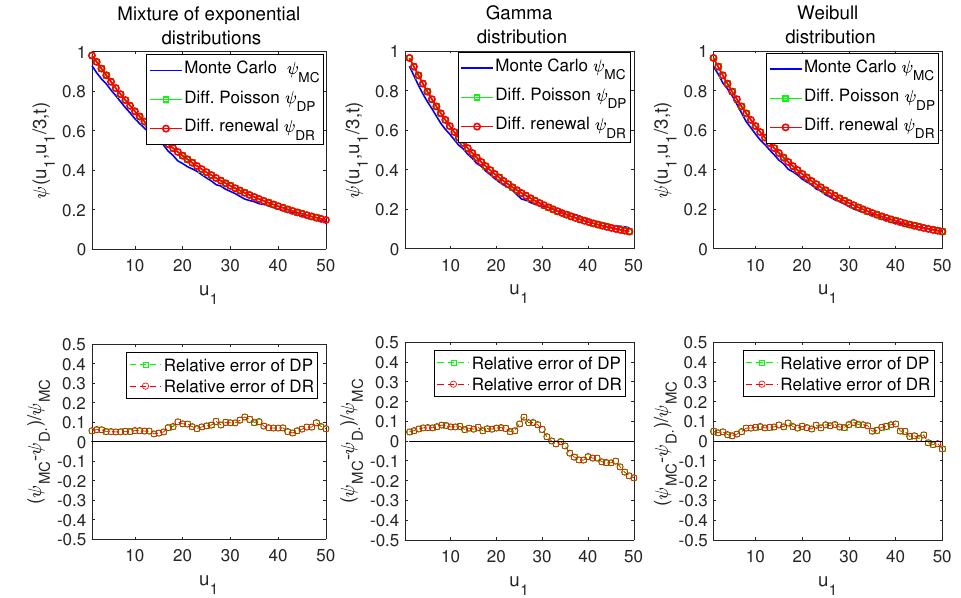
Figure 1. Ruin probabilities ( top panels) for the insurer–reinsurer model in the finite-time horizon calculated using Monte Carlo (MC) simulations with the renewal process with α = 10, σ M = 0.1, the diffusion approximation with the Poisson process (DP) with λ = 10 and the diffusion approximation with the renewal process (DR) for selected light-tailed distributions. Respective relative errors ( bottom panels) of the approximations. In the simulations t = 100, number of MC iterations is 10,000, parameters of claim distributions are given by Equations